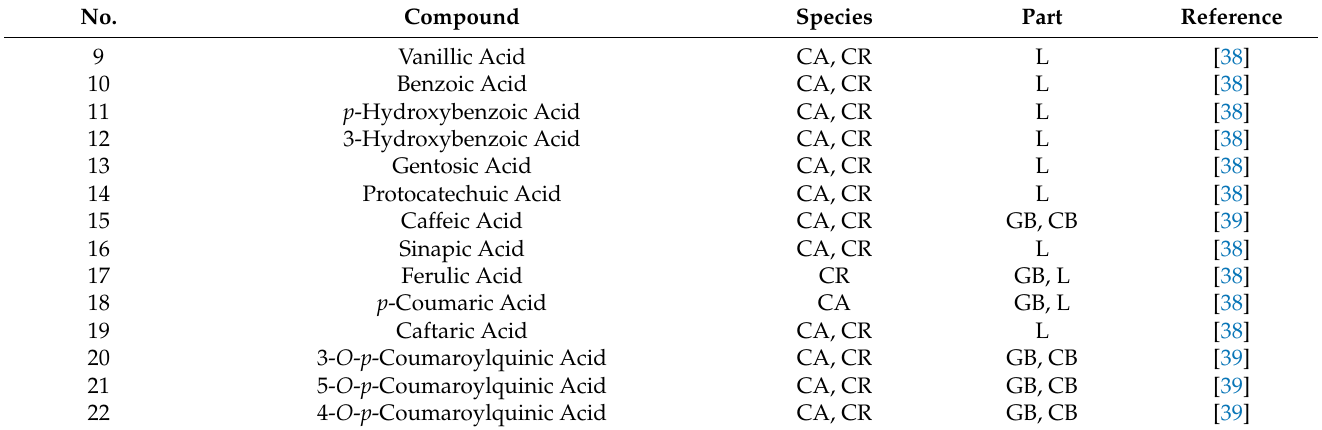
Table 3. Phenolic acid compounds in